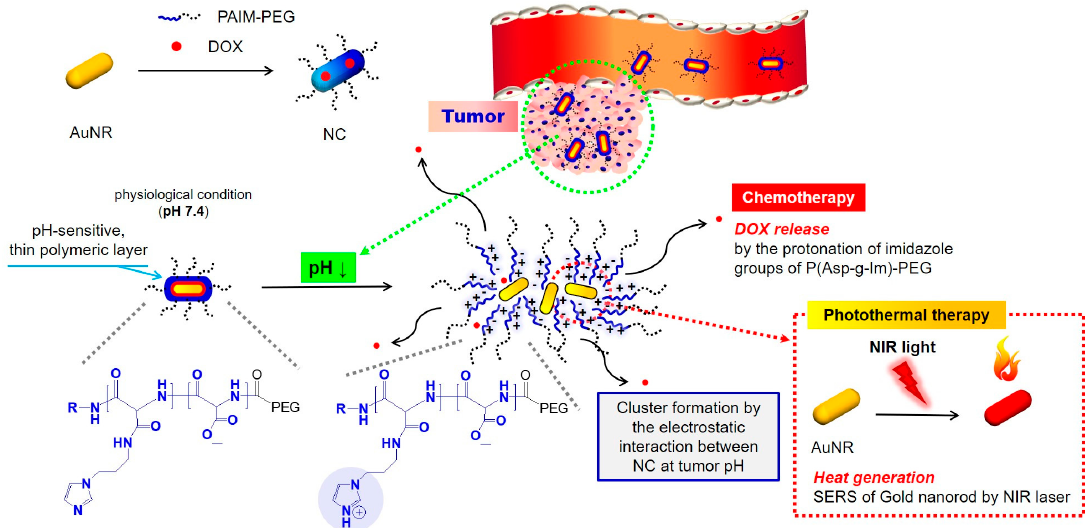
Figure 4. Graphical abstract of pH-sensitive NC system with gold nanorods and Dox using PAIM-PEG. AuNR: gold nanorods; NC: nanocluster; Dox: doxorubicin; PAIM-PEG: poly (aspartic acid-graft- imidazole)-poly(ethylene glycol) [131].